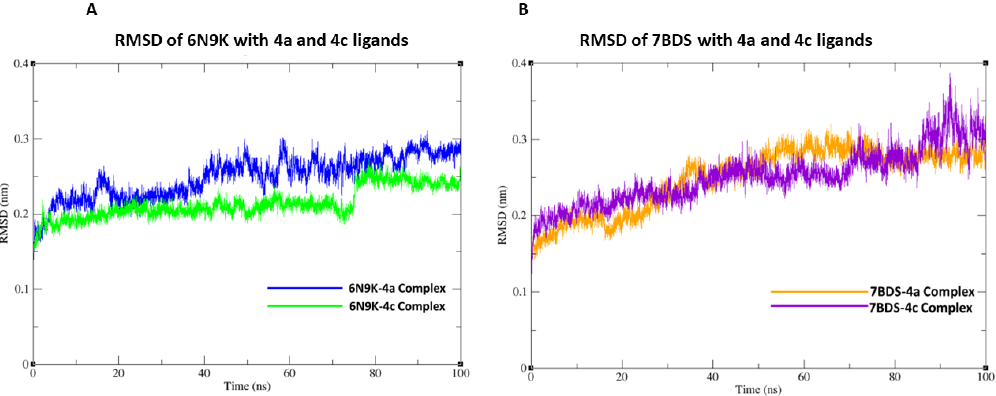
Figure 8. Root-Mean-Square Deviation (RMSD) graph of protein backbone with ligands at 100 ns simulation. ( A ) RMSD plot of 6N9K with 4a and 4c ligands. ( B ) RMSD plot of 7BDS with 4a and 4c ligands.